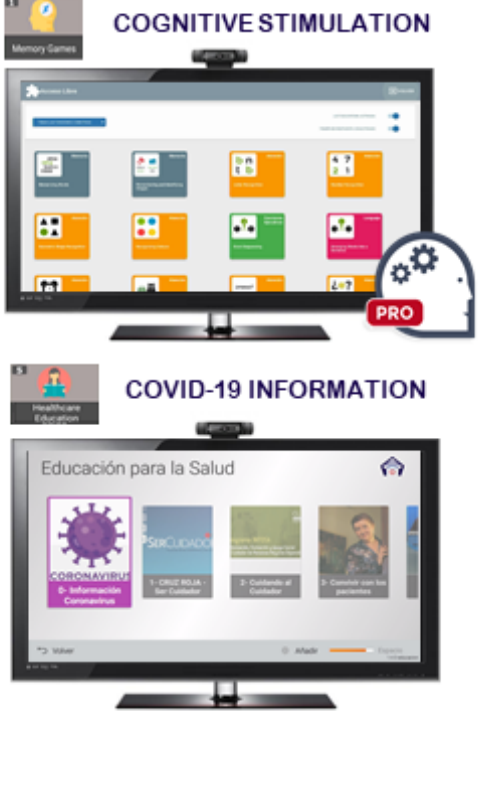
Figure 2. TV-AssistDem focused on cognitive stimulation and COVID-19